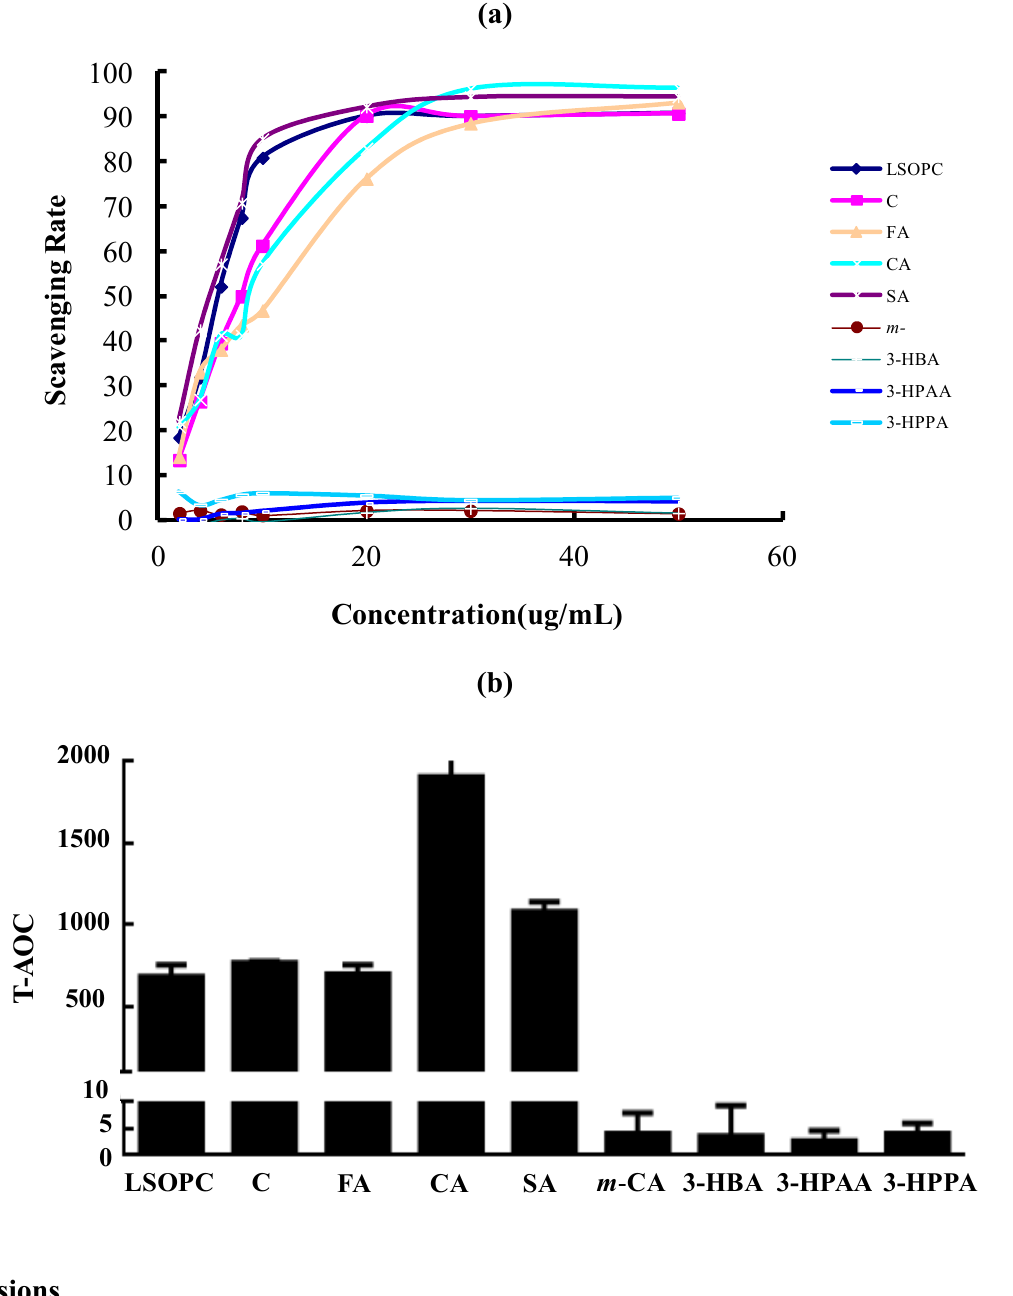
Figure 4. DPPH radical scavenging activity (a) and total antioxidant capability (T-AOC) (b) of LSOPC and its metabolites ( n = 3). C, (+)-catechin; FA, ferulic acid; CA, caffeic acid; SA, syringic acid; m -CA, m -coumaric acid; 3-HBA,